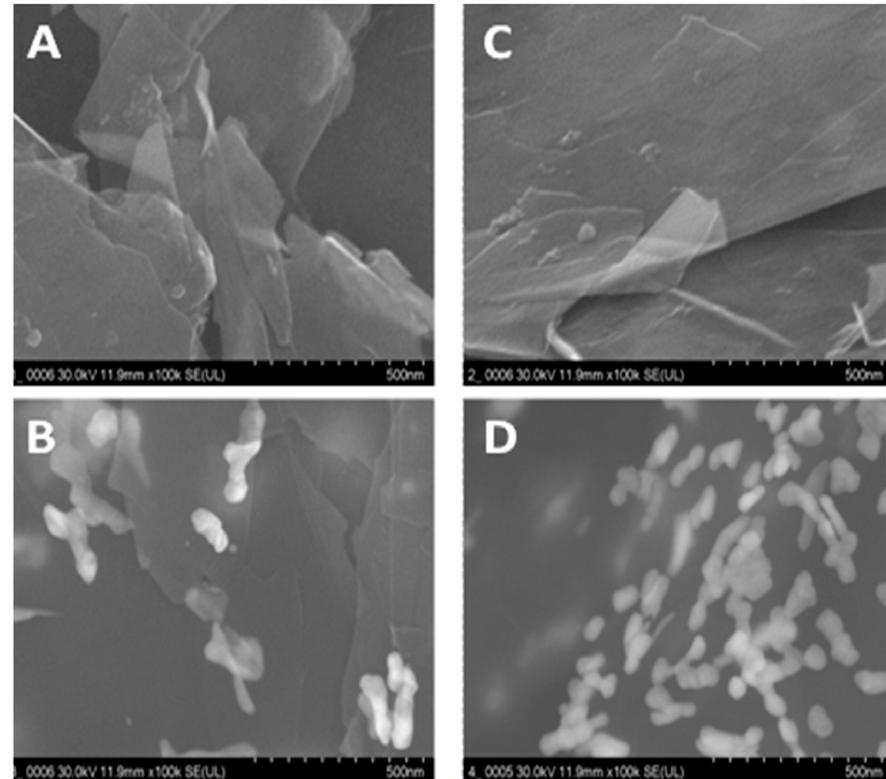
Figure 4. ( A ) SEM graphs for graphene/graphite SPE, ( B ) graphene/graphite SPE after AuNPs electrochemical generation, ( C ) graphene/graphite SPE after electrochemical reduction, and ( D ) graphene/graphite SPE after electrochemical reduction and AuNP electrochemical generation.